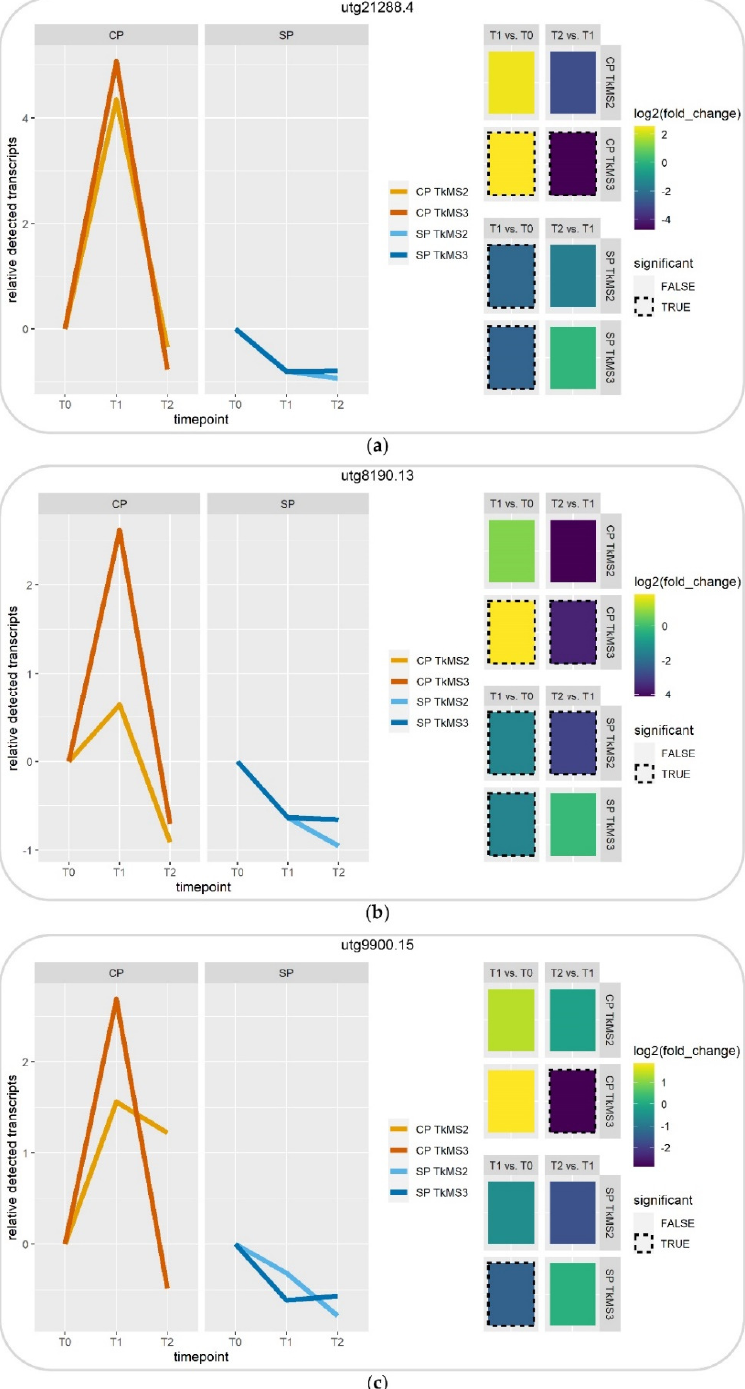
Figure 4. Visualization of relative transcript levels and log 2 fold-changes of selected differentially expressed genes (DEGs) at different time points of cross-pollination (CP) and self-pollination (SP). The x-axes in the left panel show the pooled time points (T0, T1 and T2) and the y-axes show the transcript levels relative to T0 during the pollen–pistil interaction. The cross-pollination TkMS2xTkMS3 (CP TkMS2) is shown in light orange and TkMS3xTkMS2 (CP TkMS3) in dark orange. The self-pollination TkMS2 (SP TkMS2) is shown in light blue and TkMS3 (SP TkMS3) in dark blue. The right panel shows the corresponding log 2 fold-changes, with significant values marked with a black dotted rectangle. The three selected DEGs are utg21288.4 ( a ), utg8190.13 ( b ) and utg9900.15 ( c ).